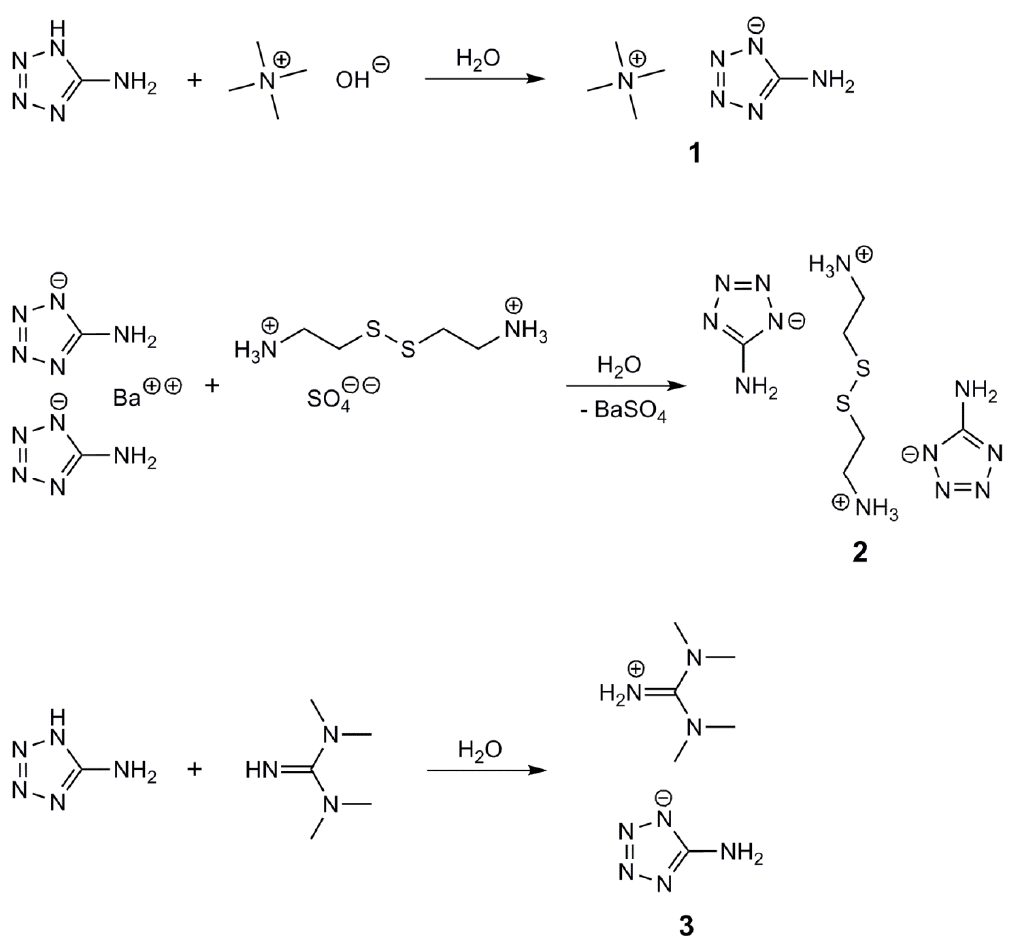
Figure 1. Synthesis of the 5-aminotetrazolates 1 – 3